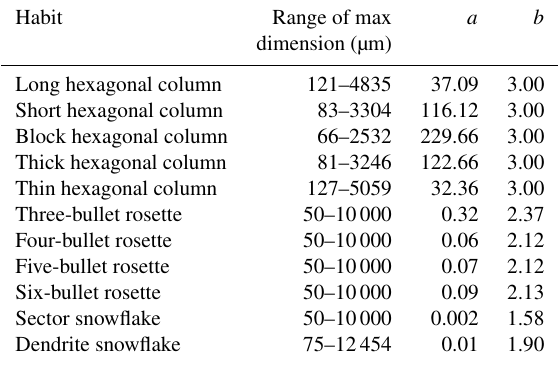
Table 2. Overview of the Liu (2008)